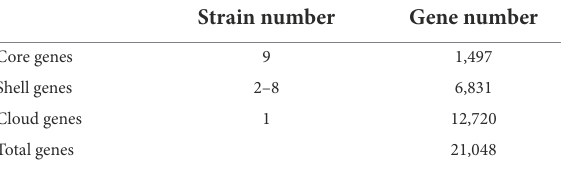
TABLE 1 The proportion of protein-coding genes in the core, shell, and cloud of eight Laspinema sp. strains and “ Oscillatoria ” acuminata PCC6304